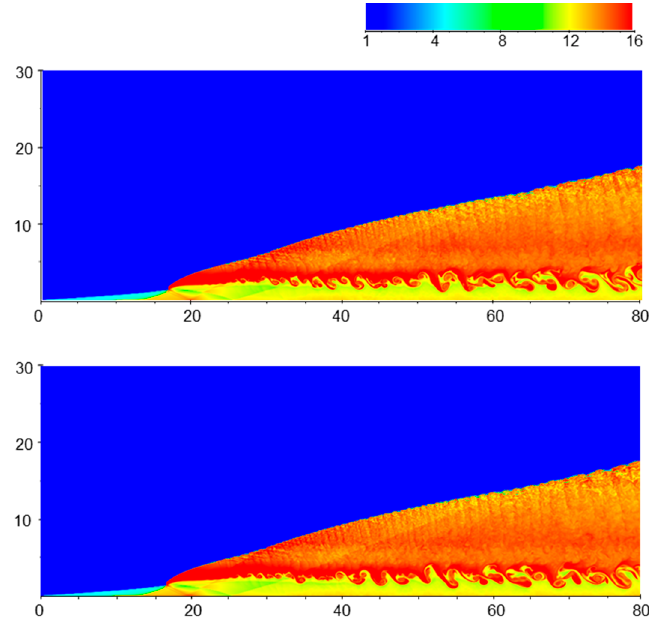
Figure 5. Temperature contours for the case M 0 = 12.5, θ = 26° and E a = 60 obtained using the one-step Arrhenius kinetics with k = 14,640 and Courant-Friedrichs-Lewy (CFL) number equal to 0.5 (upper); and 0.25 (lower).